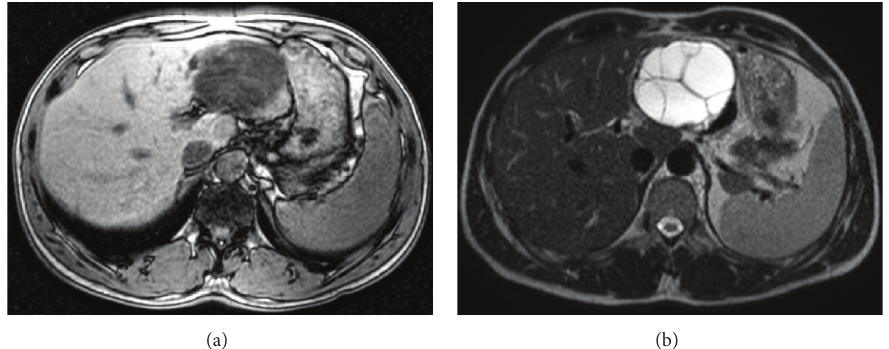
Figure 2: Magnetic resonance imaging of this tumor revealed low contrast intensity in the T1 weighted image (a) and high intensity in the T2 weighted image